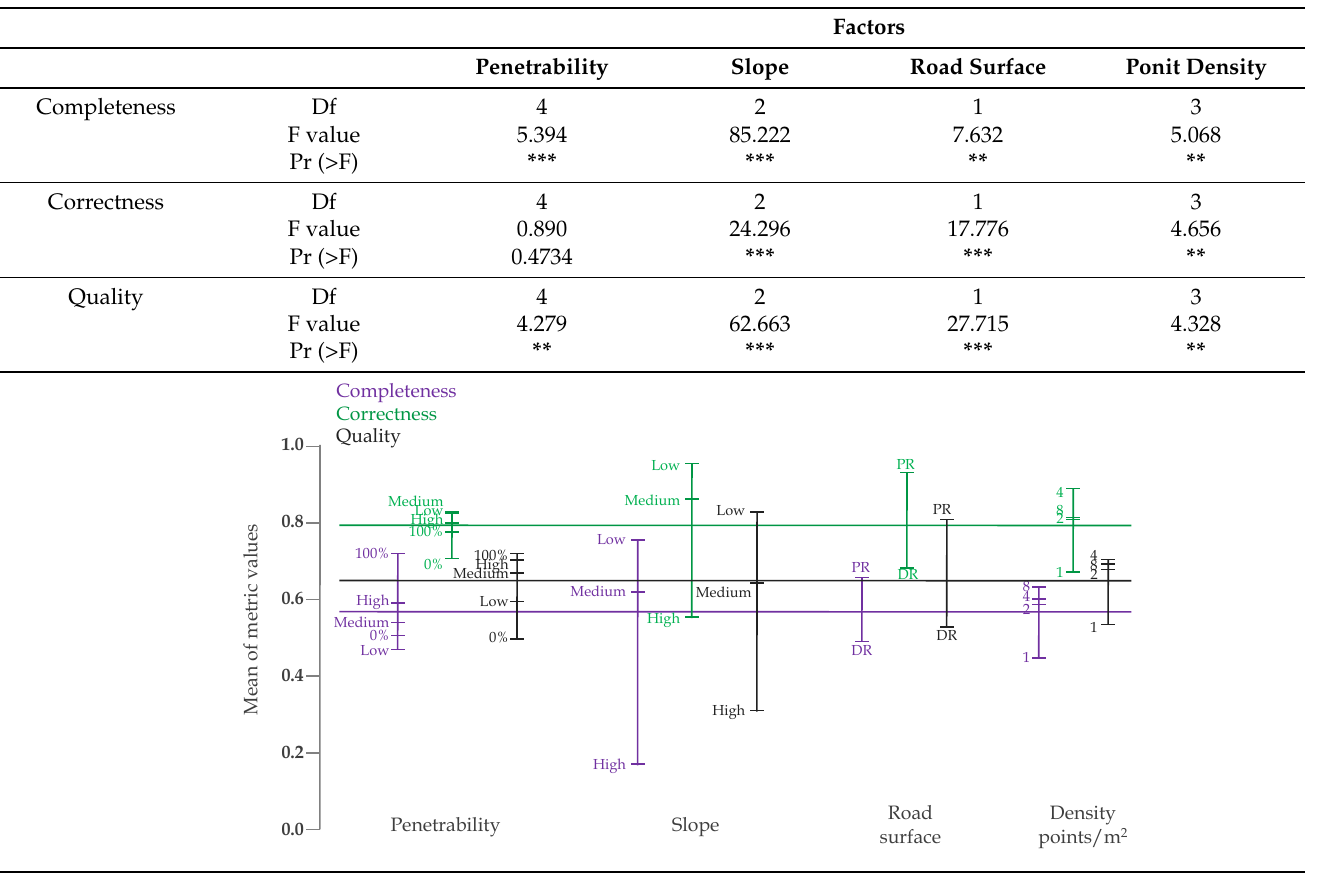
Table 4. Analysis of variance (ANOVA) for the effects of penetrability, slope, road surface and point density on the quality measures and figure shows the results of plot.design